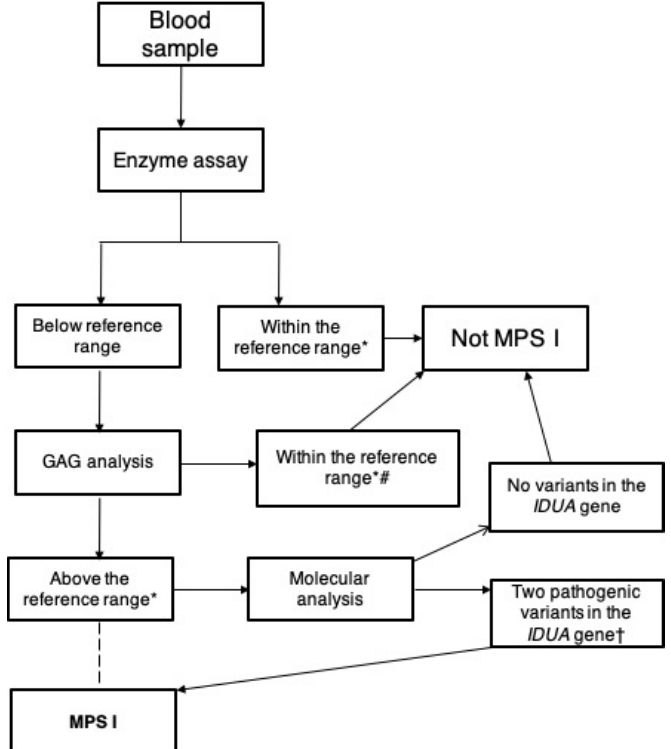
Figure 3. Flowchart for the newborn screening of MPS I (this flowchart could be used to investigate symptomatic subjects, although in these cases the investigation usually starts with the quantitative and / or qualitative evaluation of urinary GAGs, positive cases being referred for the blood testing). * Reference ranges for alfa-L-iduronidase (IDUA) and glycosaminoglycans may vary according to the methodology used and must be established in each laboratory. # Pseudodeficiency leading to low IDUA levels with normal GAG levels. † Careful examination should be performed with variants of unknown significance (VUS). If no variant is found with Sanger or next-generation sequencing, other techniques such as multiplex ligation-dependent probe (MLPA) should be performed. It is also always recommend to analyze the trio (proband and parents). The dashed line for MPS I diagnosis represents the choice of some laboratories to report a diagnosis solely based on enzyme levels and GAG analysis without molecular analysis of the IDUA gene; this approach has been used in NBS at some centers.